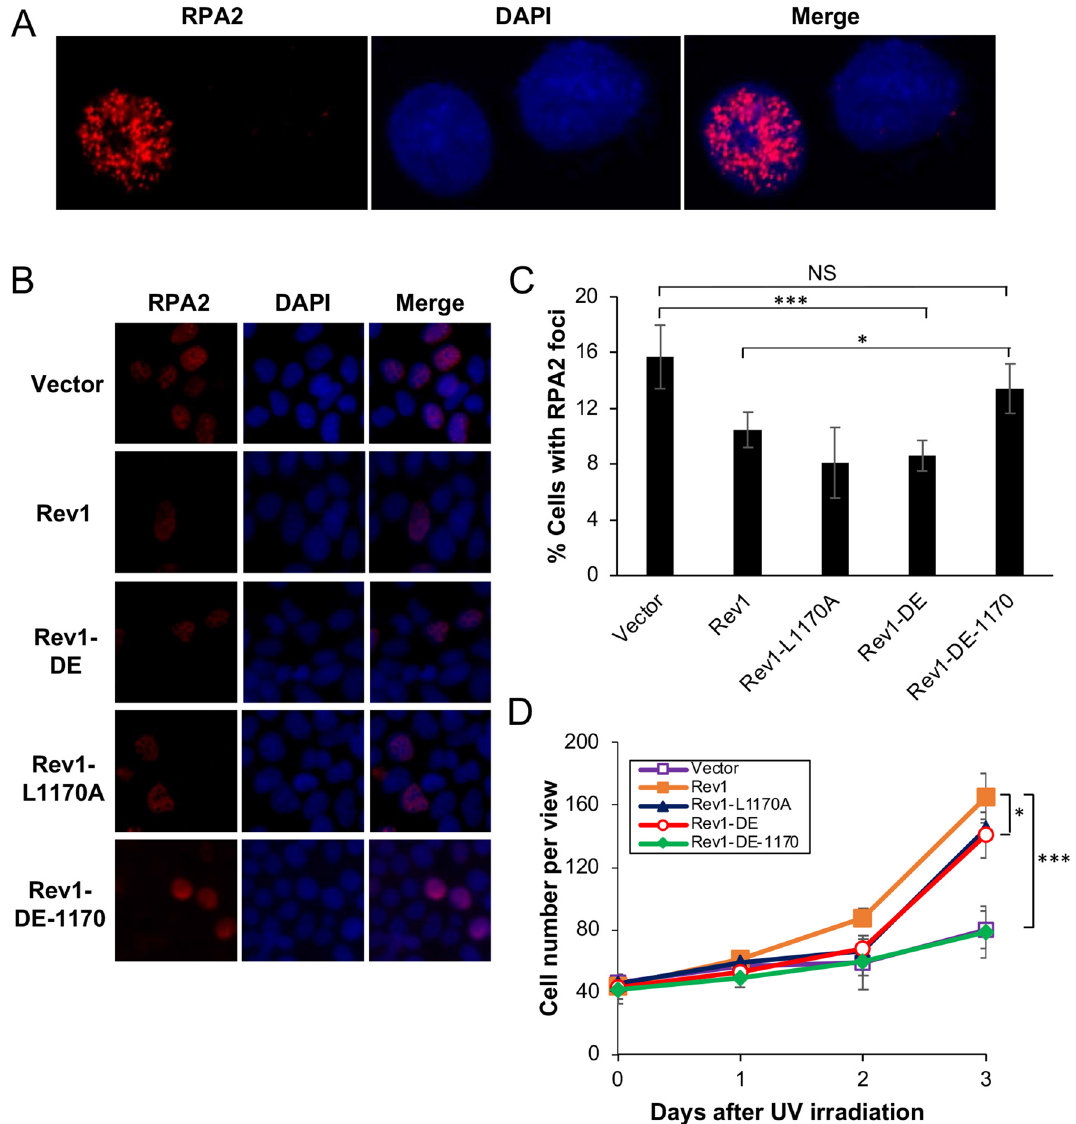
Figure 1. Effects of Rev1 and its mutant derivatives on cellular tolerance to UV irradiation in 293T cells. ( A, B ) Representative images of an RPA nuclear focus formation assay. 293T cells were transfected with plasmids expressing GFP-Rev1 or its mutations. 48 h later, these cells were irradiated by 8 J/m 2 UV and incubated for 6 h before staining with DAPI or an antibody against RPA2. ( A) represents typical RPA2-positive (left) and RPA2-negative (right) cells. ( C ) Quantitative analysis of data from ( B) . ( D ) Effects of Rev1 and its mutations on 293T cell growth in response to UV irradiation. Cells were transfected with plasmids expressing wild-type or indicated Rev1 point mutations for 2 days before 30 J/m 2 UV irradiation. ( C , D ) Data are means of three independent experiments ± SEM. *, P < 0.05; ***, P < 0.001; NS, not significant by two-sided Student’s t